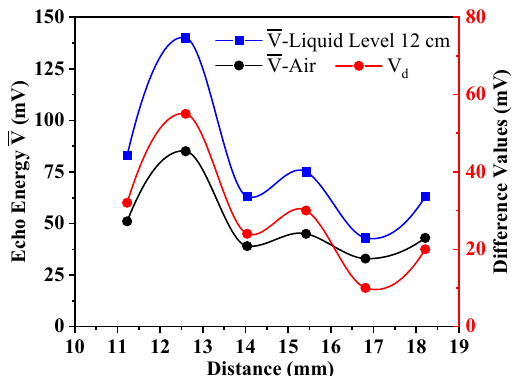
Figure 7. The impact of ultrasonic wavelength on experimental results.